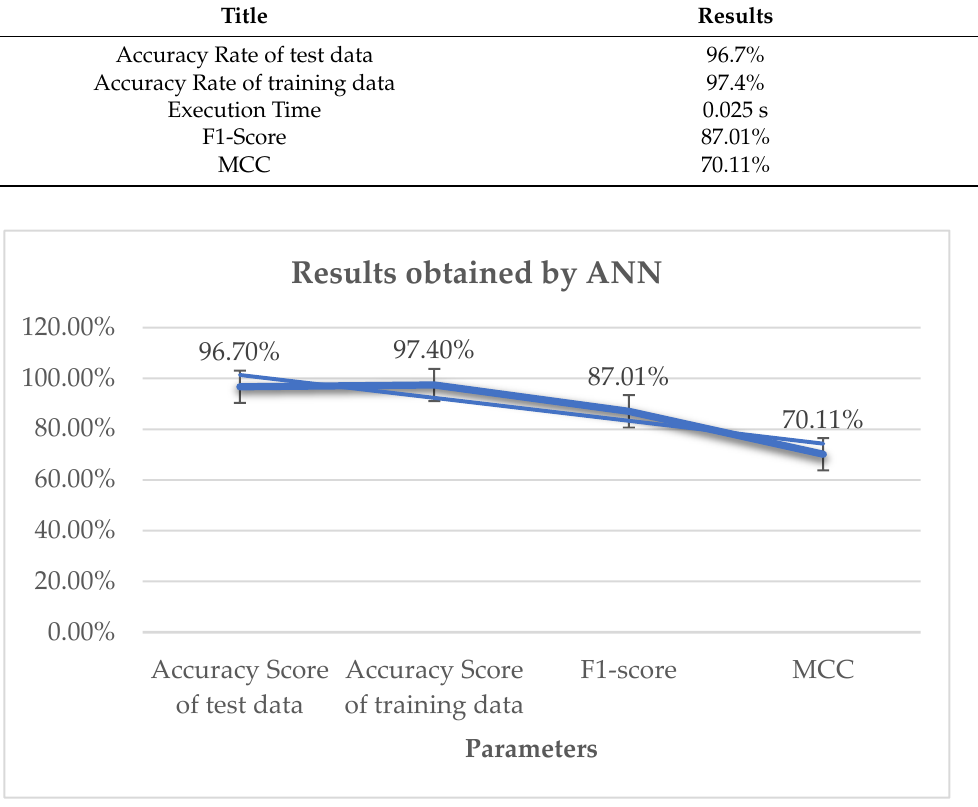
Figure 8. Results obtained by ANN.